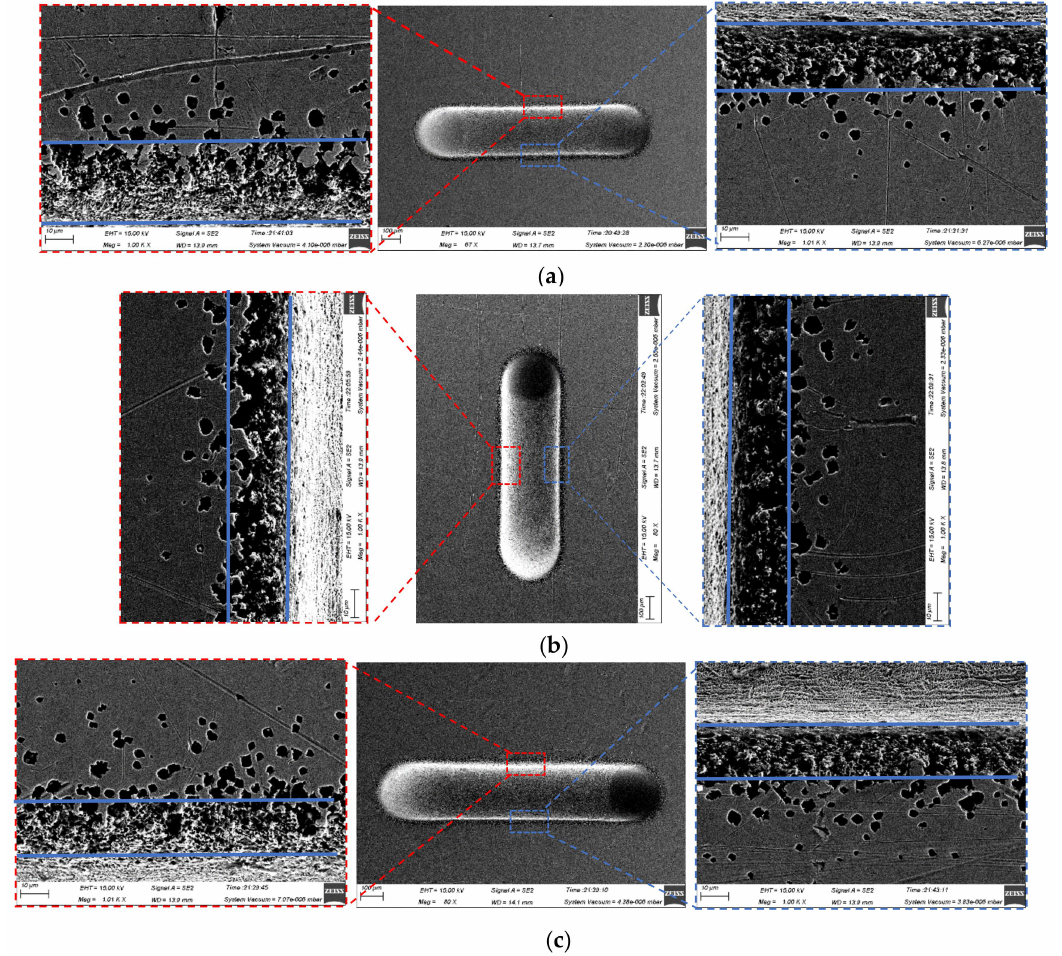
Figure 15. SEM images of micro-grooves machined with the translating machining mode when the electrical voltage was 20 V, the translating speed was 200 µ m / s, the nozzle’s inner diameter was 170 µ m, and the working gap was 100 µ m. ( a ) Vertically downstream mode; ( b ) translating vertically in the horizontal mode; ( c ) translating horizontally in the horizontal